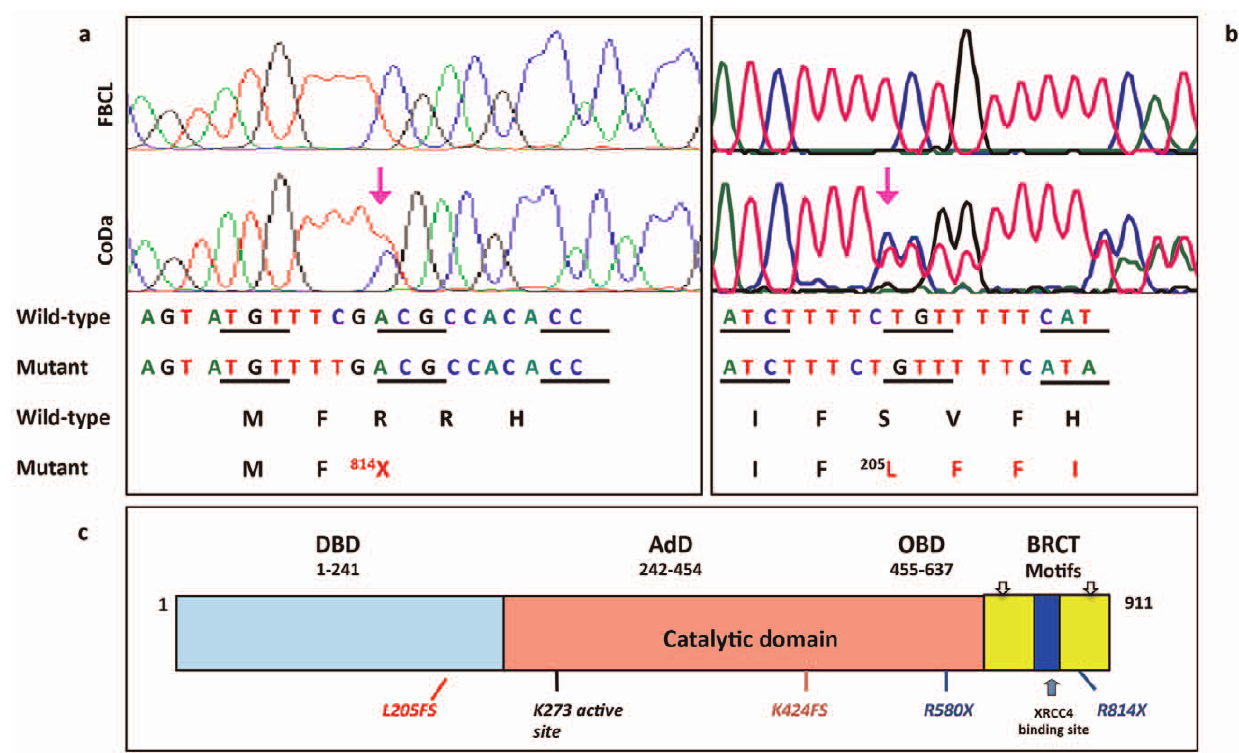
Figure 8. Mutations of LIG4 identified in CoDa genomic DNA. Shown are sequencing results from control fibroblast FBCL (Wild-type) and CoDa cells (mixture of wild-type and mutated alleles). (a) The 2440C . T (R814X) mutation. Single nucleotide mutation (C . T) at position of 2440 of coding region changes Arg-814 to stop codon, which results in premature truncation of the DNA ligase IV protein. (b) The 613 D T mutation. Single nucleotide deletion at nucleotide position 613 of coding region leads to a frame shift at L205 (L205FS) and causes a premature stop codon 18 aa downstream. Mutated amino acids are labeled with numerical number in protein sequence and shown in red. Pink arrows indicate the location of mutated nucleotides. (c) The schematic structure of DNA Ligase IV protein (Adapted from Marchetti et al. [36]). LIG4 comprises three domains: DNA- binding domain (DBD), adenylation domain (AdD) and oligo-binding domain (OBD). AdD and OBD form the catalytic domain. Two C-terminal BRCT motifs and XRCC4-binding sites (grey) are required for interaction with XRCC4. Localization of truncation mutations found in the LIG4 is labeled in the panel.